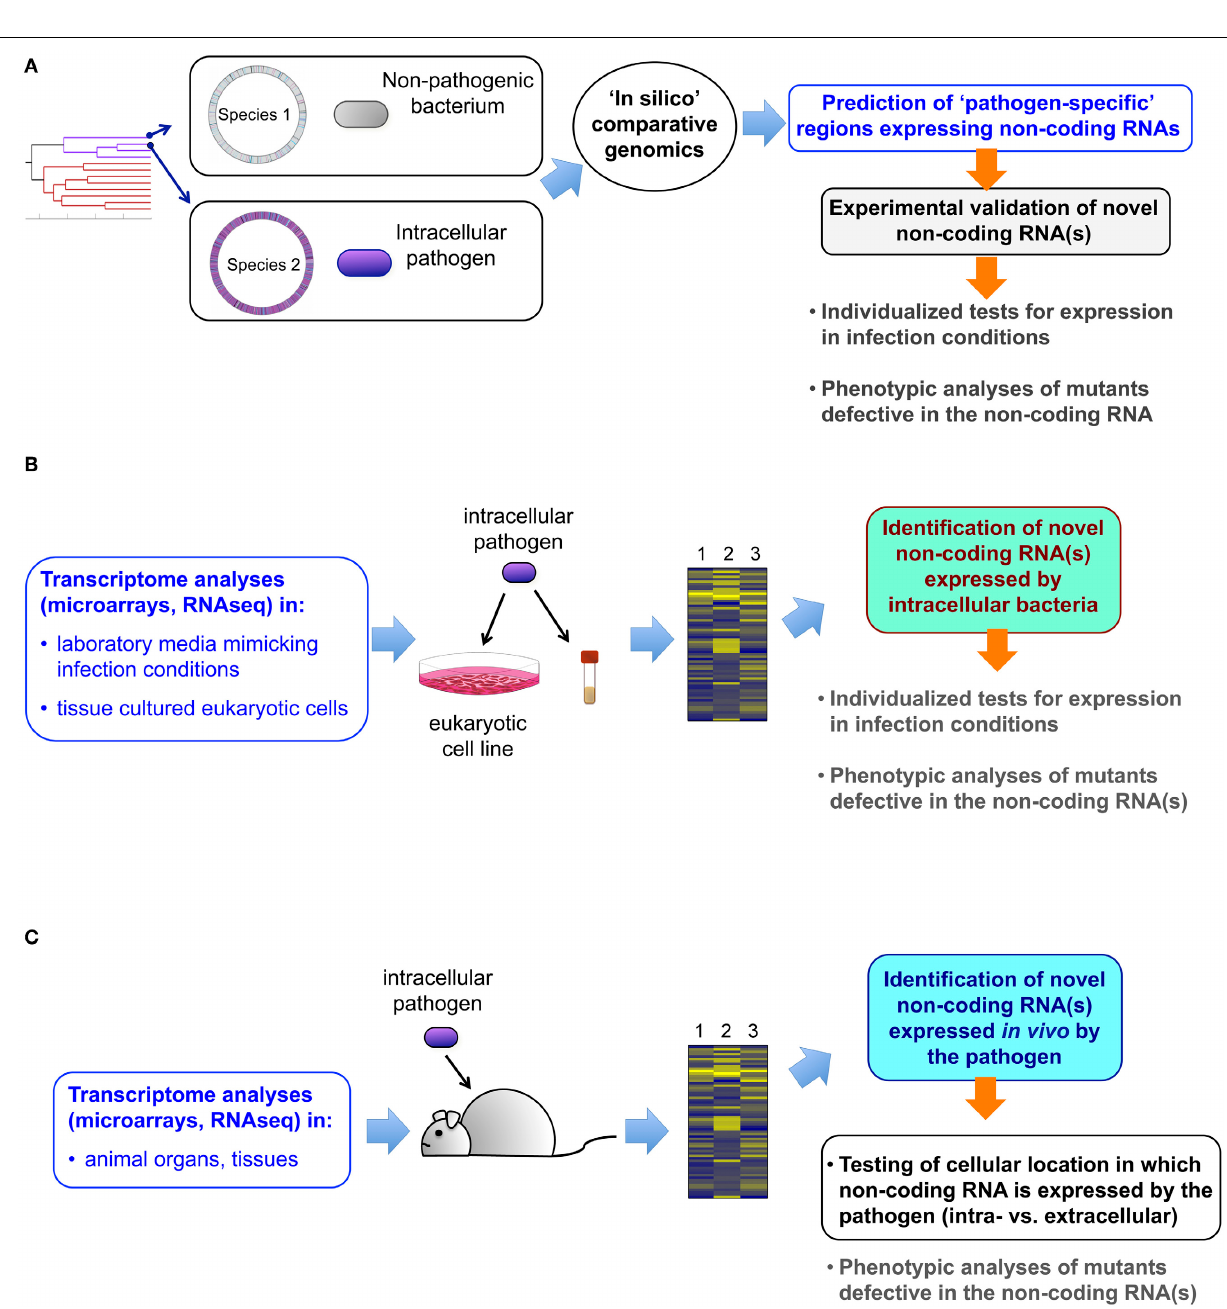
or, (ii) in bacteria isolated from eukaryotic cells infected in in vitro using tissue cultured cells. These new non-coding RNAs are further validated experimentally and tested for putative role in virulence using defective mutants; (C) Transcriptomic data including information about non-coding RNA can also be obtained from the pathogen grown in tissues or organs of the animal. Although this approach does not provide a direct proof of production of the non-coding RNA in bacteria located inside the host cell, this possibility can be further tested in tissue culture cells. Experimental validation of the non-coding RNA and testing of its putative role in virulence are logical subsequent